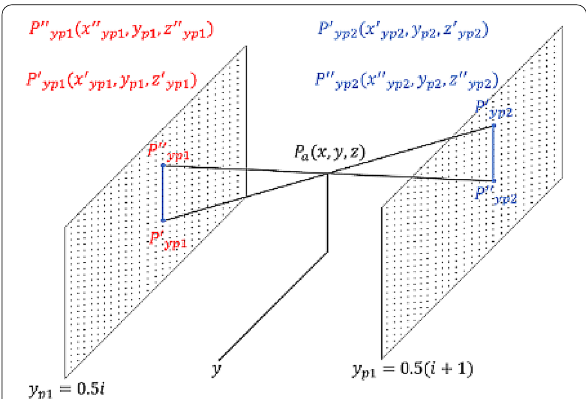
Figure 4 A schematic of the mapping between the two image coordinates and their world coordinates